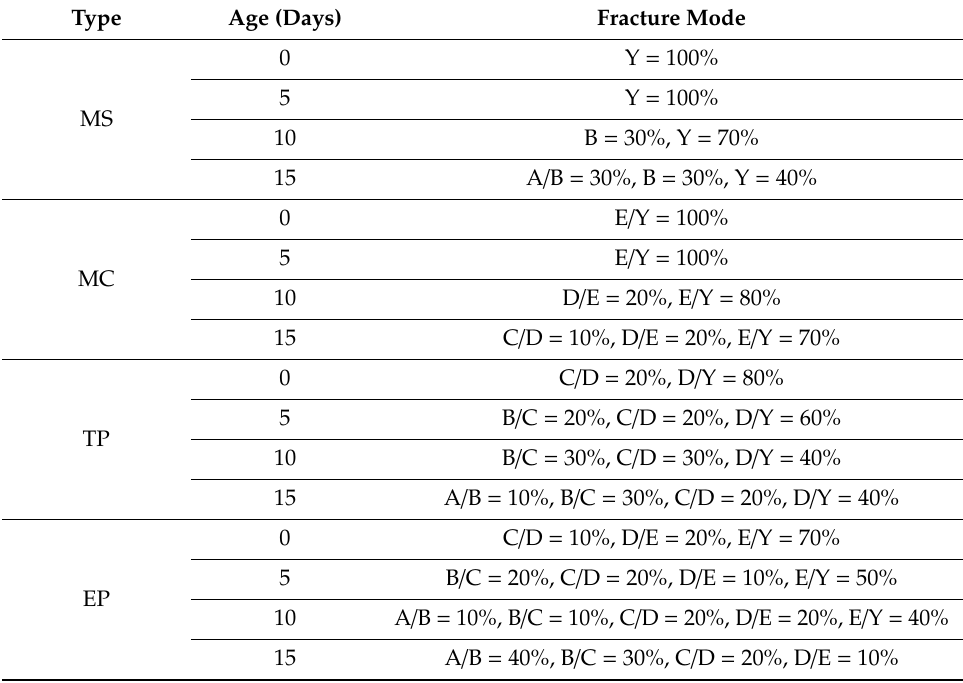
Table 7. Adhesion test results of coating systems exposed to salt spray test (ASTM B